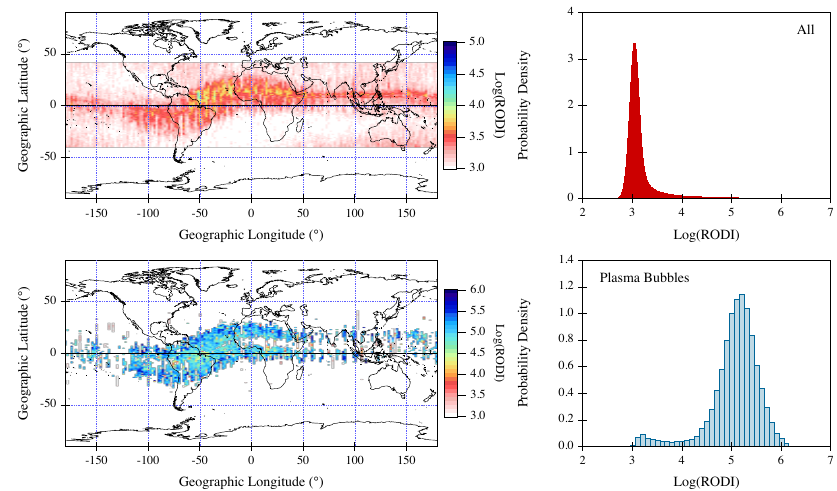
Figure 4. ( Top ): Rate of change Of electron Density Index (RODI) values associated with electron density data selected under the following conditions: 18:00–24:00 LT, ± 40 ◦ geographic latitude, and Kp ≤ 3 in the latitude–longitude plane ( left ) and corresponding probability density ( right ). ( Bottom ): RODI values associated with the plasma bubbles in the latitude–longitude plane ( left ) and corresponding probability density ( right